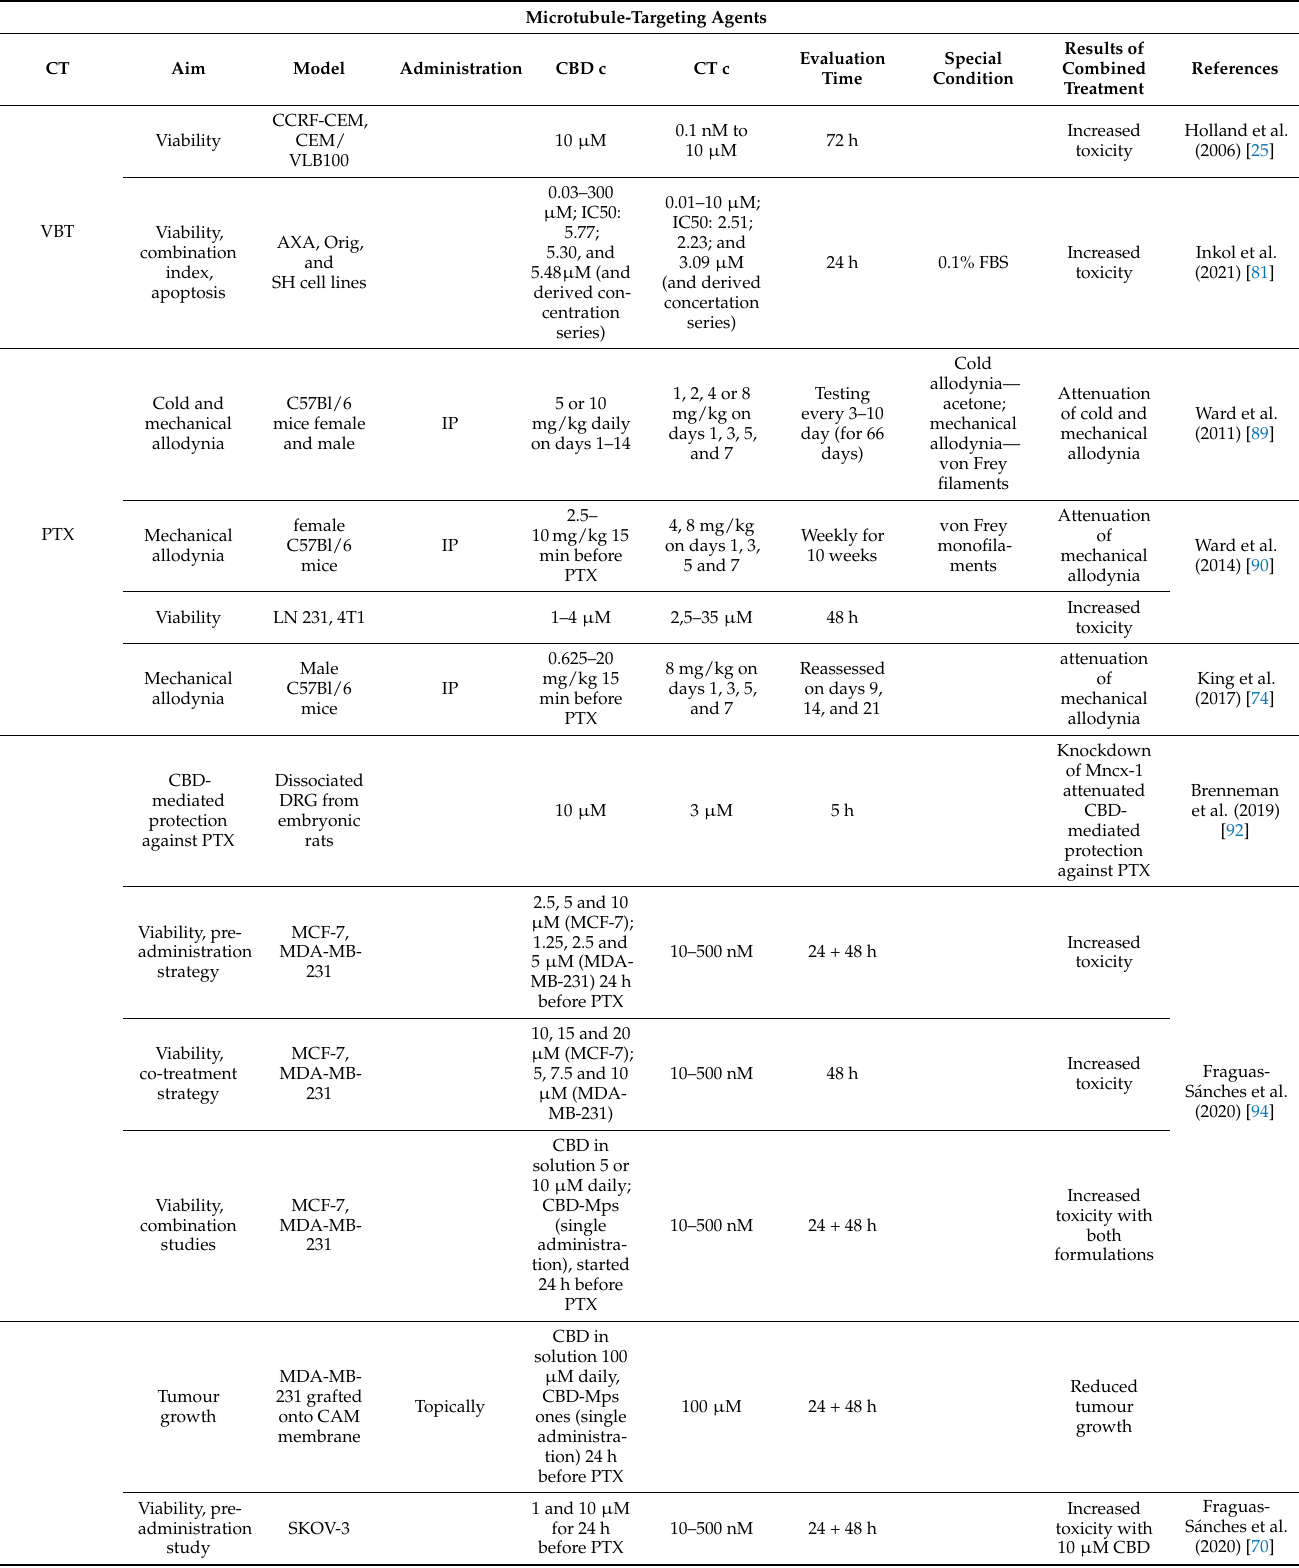
Table 3. Summary of the drug–drug interactions of CBD with microtubule-targeting